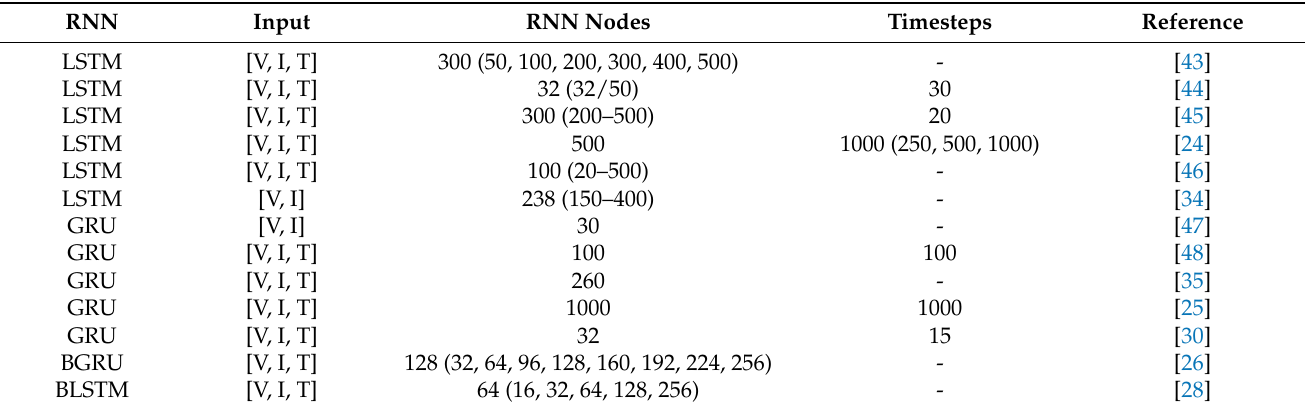
Table 2. The numbers of RNN nodes and timesteps chosen and